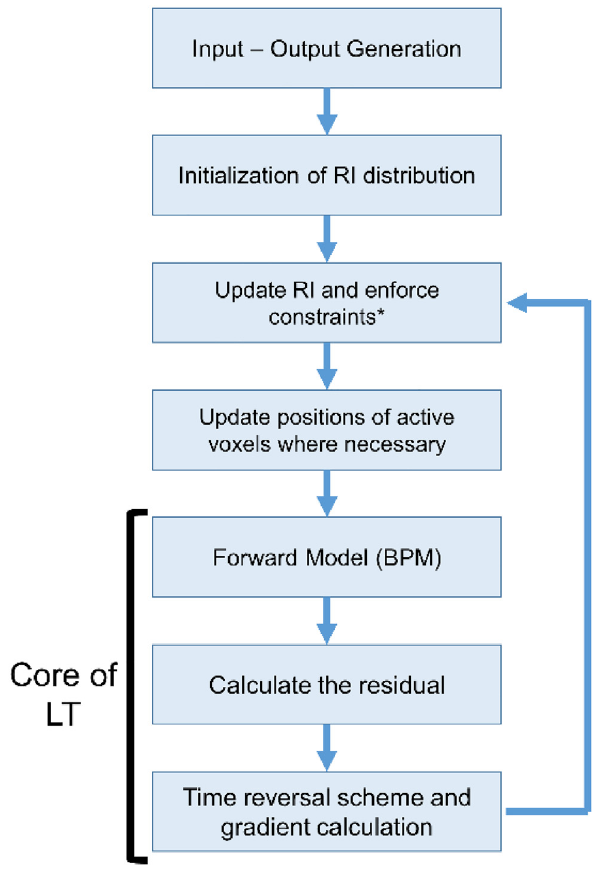
Figure 3: The scheme of the optimization based on LT. *Possible constraints are voxel averaging, RI limitations and thickness